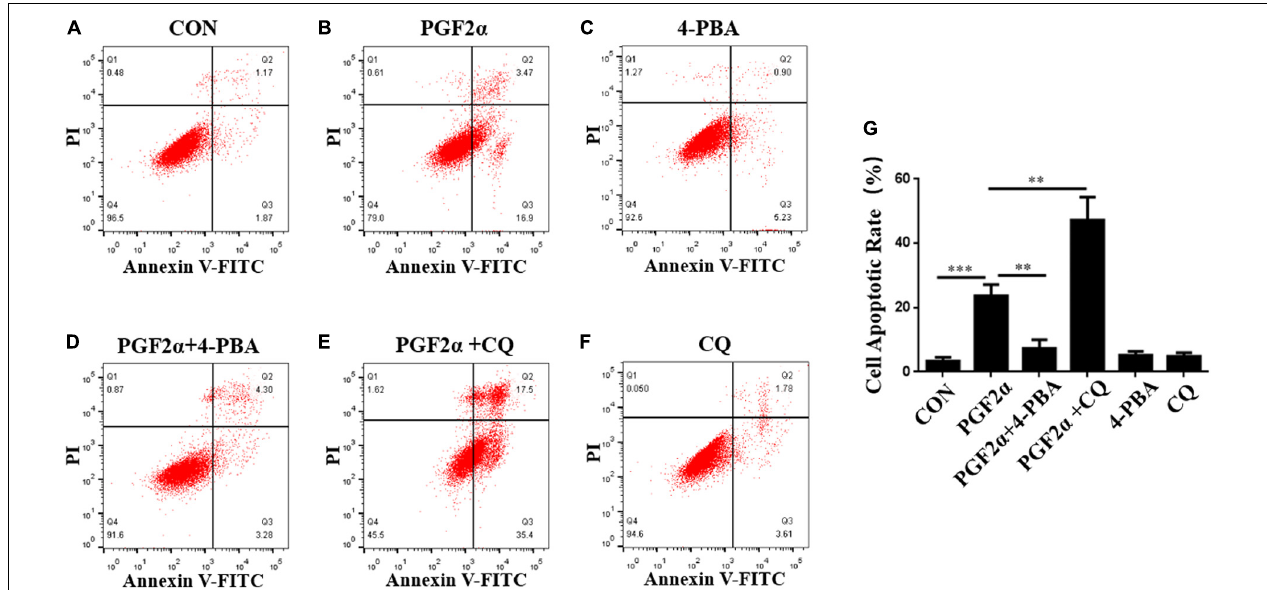
FIGURE 3 | ER stress and autophagy regulate goat luteal cell apoptosis induced by PGF2 α . (A–F) Cells cultured in medium with PBS, PGF2 α (1 µ M), PGF2 α (1 µ M), and 4-PBA (1 µ M) to inhibit ERS or PGF2 α (1 µ M) and CQ (100 µ M) to inhibit autophagy,4-PBA (1 µ M) and CQ (100 µ M) for 24 h are stained with annexin V-FITC/PI and analyzed by flow cytometry. (G) The histogram shows the apoptotic rate displayed in A-F from three separate experiments ( N = 3). Means are compared with one-way ANOVA combined with Tukey’s post hoc tests. ∗∗ p < 0.01, ∗∗∗ p < 0.001.